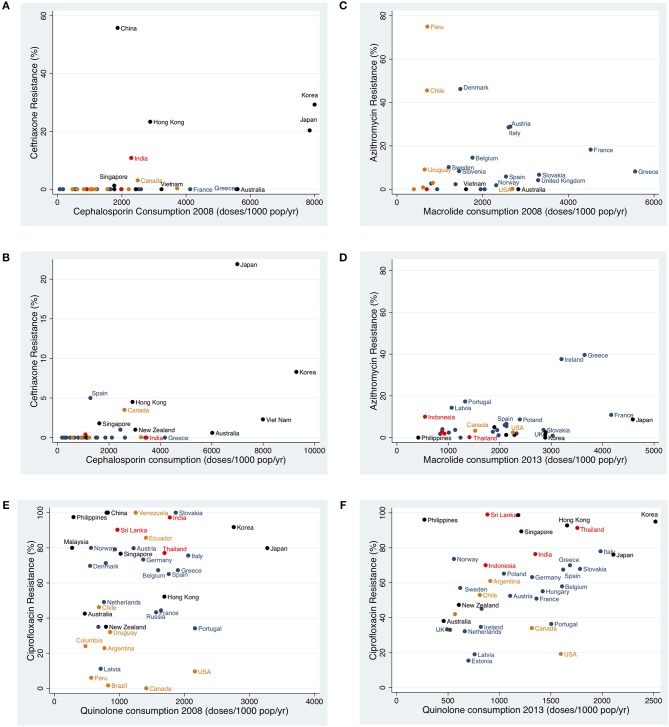
Scatter plots of antimicrobial consumption vs. antimicrobial resistance in the subsequent year for (A) ceftriaxone in 2008 (B) ceftriaxone in 2013 (C) azithromycin in 2008 (D) azithromycin in 2013 (E) ciprofloxacin in 2008 (F) ciprofloxacin in 2013 (Black, Western Pacific; Red, South East Asia; Yellow, Americas; Blue, Europe).